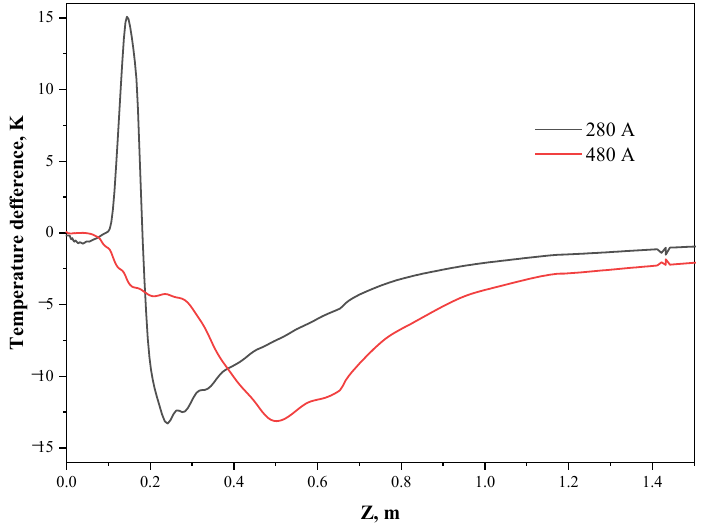
Figure 19. Distribution of surface temperature difference between inner and outer arc sides.